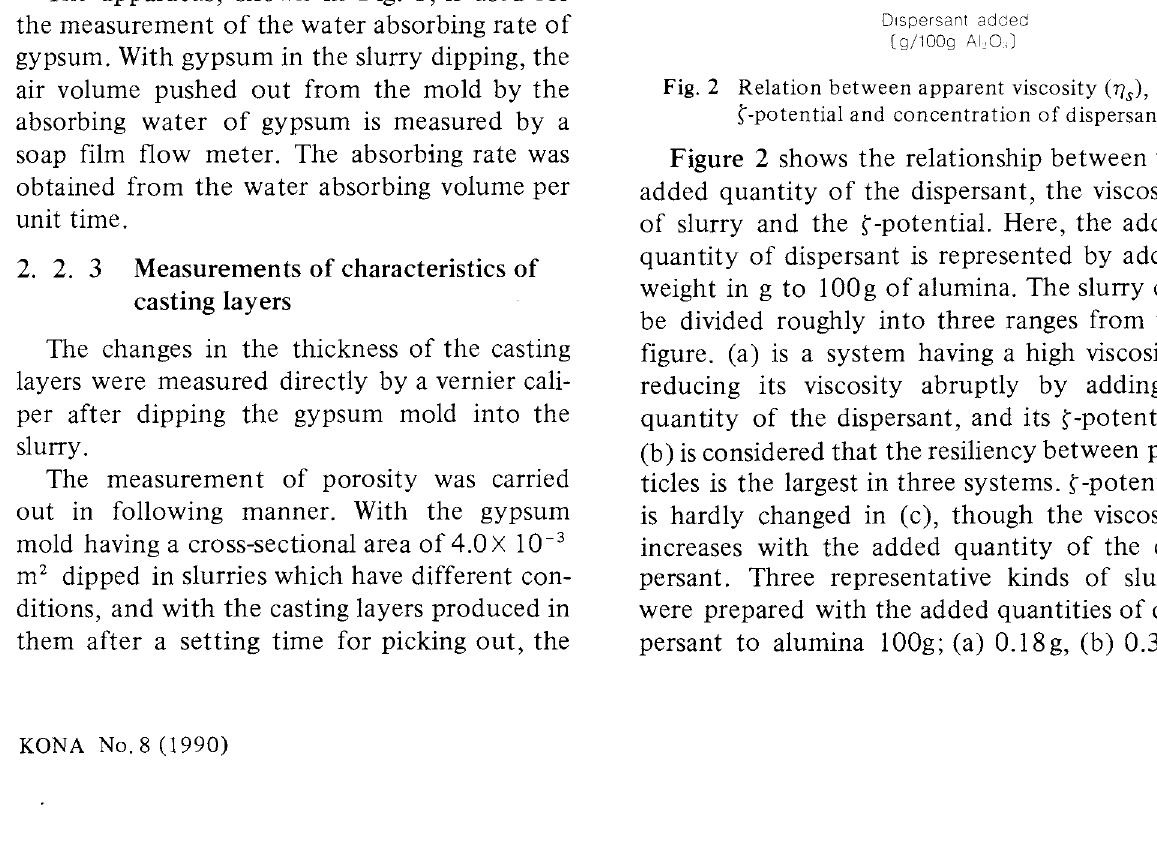
Fig. 1 Apparatus for measurement of water absorbing rate